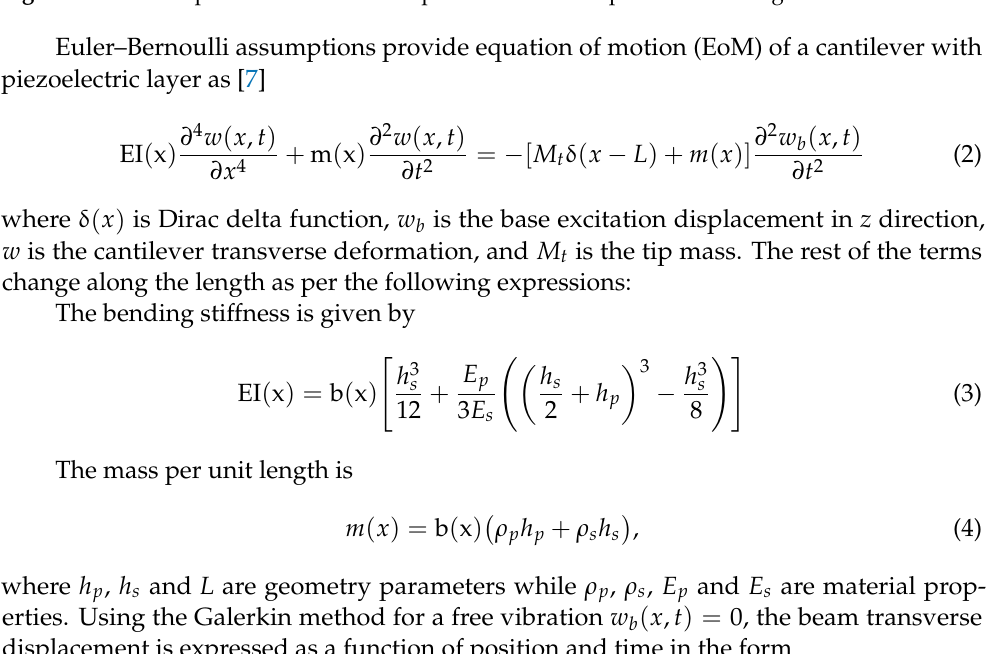
Figure 3. Mode shape of the continuous tapered beam with tip mass before